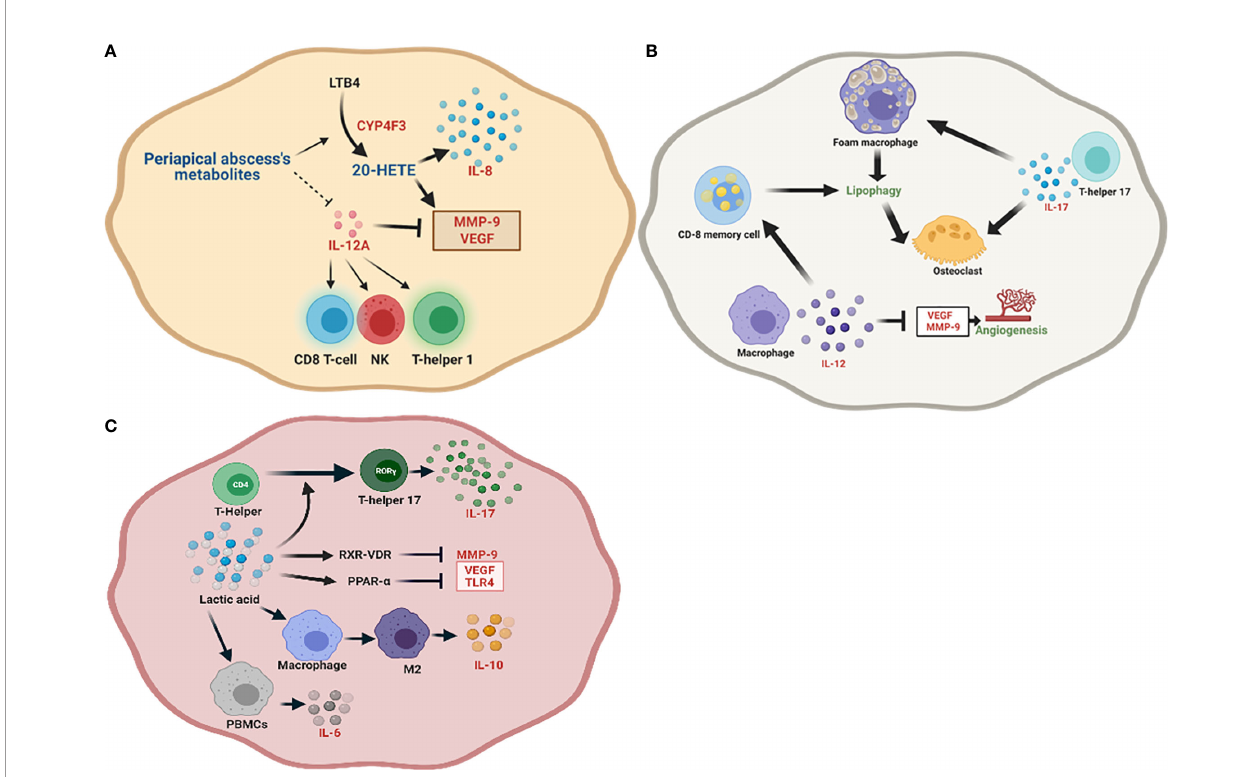
FIGURE 8 | Schematic representation of the identi fi ed unique metabolites, enrichment pathways, and proposed genes and their roles in the initiation and progression of each periapical lesion. (A) In periapical abscess, the unique metabolic environment stimulates the conversion of leukotriene B4 (LTB4) to 20-HETE and the downregulation of IL-12A. In turn, these upregulate the expression of MMP-9 and VEGF. IL-12A also stimulates the differentiation of naive T cells to T-helper 1 cells and stimulates NK cells and CD8 cytotoxic T lymphocytes. (B) In radicular cyst, IL-12 enhances the effector CD8 T cells and memory CD8 T cells. Released IL-12A inhibits VEGF and MMP-9 and hence reduces angiogenesis, while lipophagy is enhanced in foam macrophages. IL-17A released from T-helper 17 directly enhances bone resorption by stimulating osteoclasts. (C) In periapical granuloma, L-(+)-lactic acid is the main unique metabolite, which polarizes the conversion of T-helper cells to T-helper 17 through the enhancement of transcription factor ROR g which supports the release of IL-17 and may stimulate RXR-VDR and PPAR- a pathways. RXR-VDR inhibits MMP-9 and PPAR- a negatively regulates VEGF and TLR4. Lactic acid also enhances the polarization of macrophages to the anti-in fl ammatory M2 phenotype while supporting IL-10